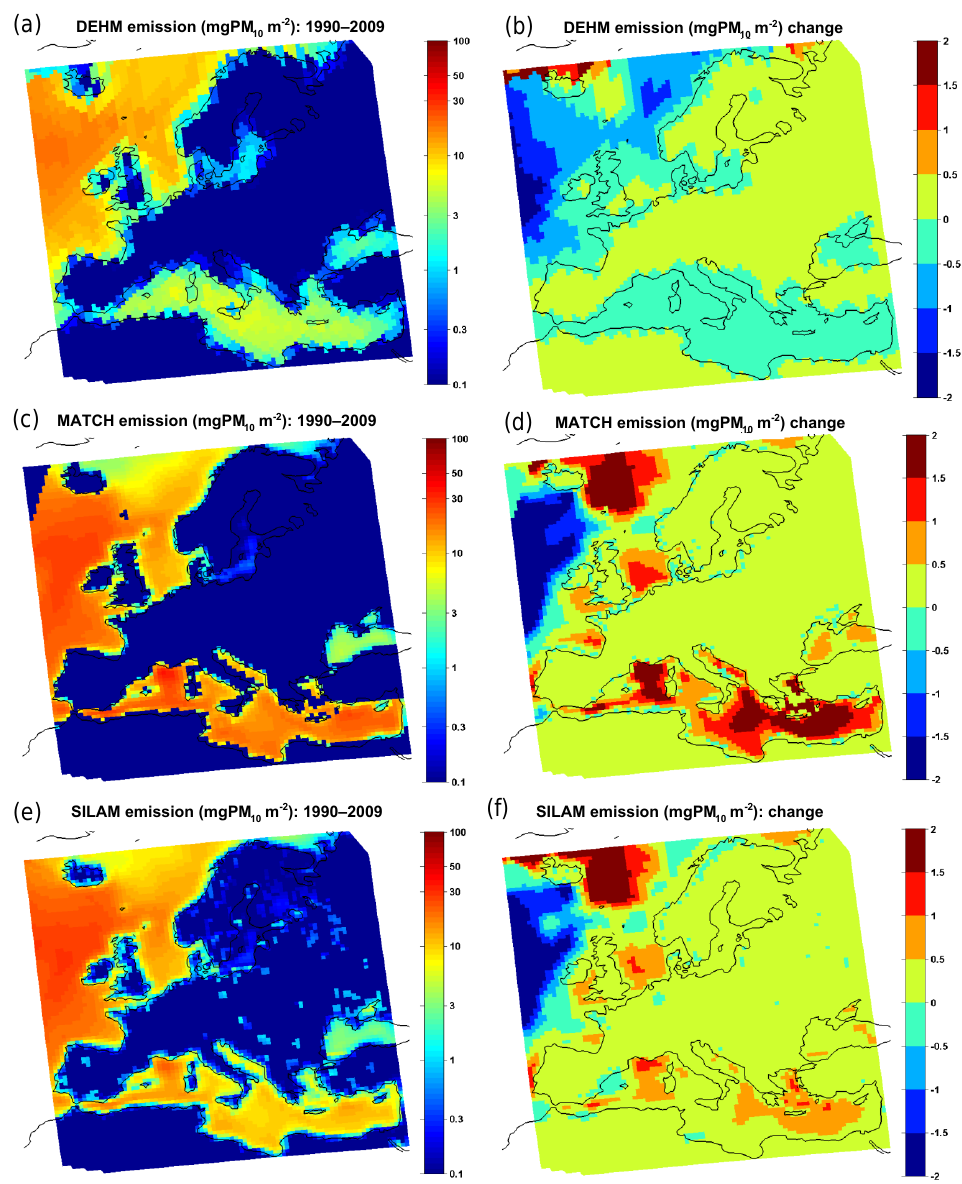
Figure 2. Annual sea salt emission (mgPM 10 m − 2 ) for DEHM, MATCH, and SILAM models. Left panels: mean value for the past period (1990–2009); right panels: absolute difference between the future (2040–2059) and past periods.